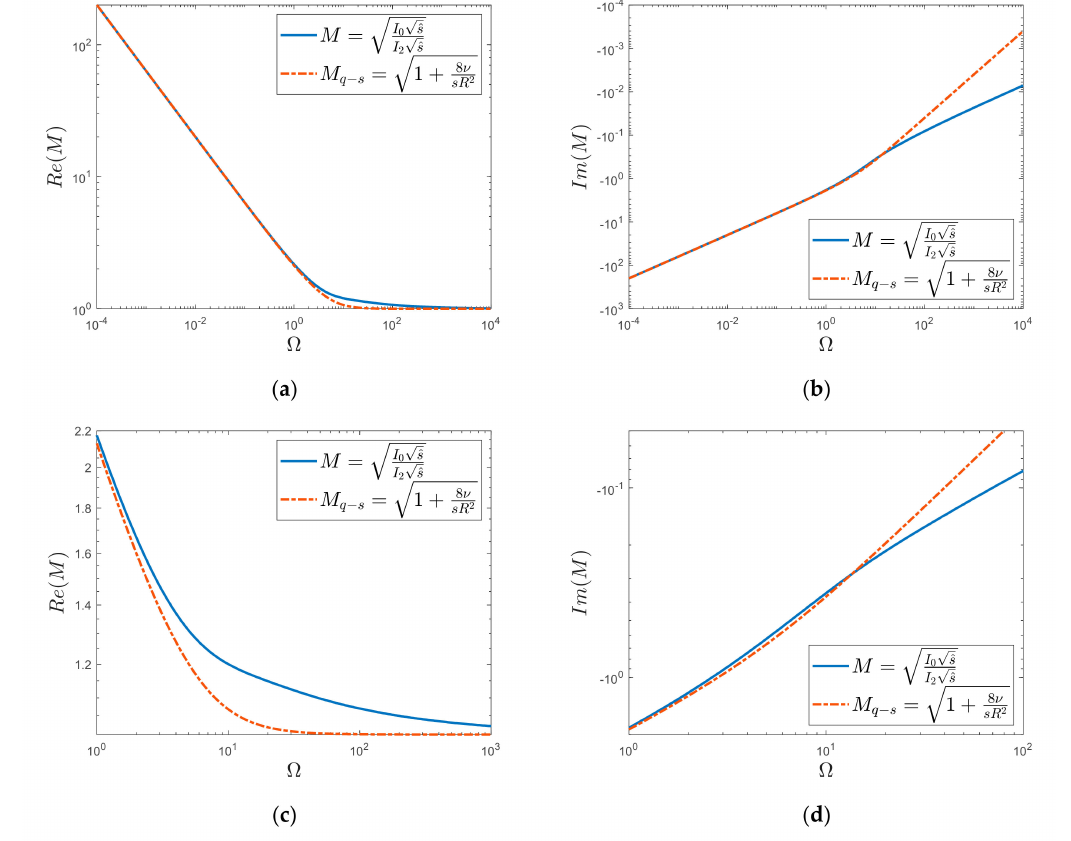
Figure 2. Course of dynamic viscosity function ( a ) Realis graph, ( b ) Imaginaris graph, ( c ) Enlarge of Realis graph, ( d ) Enlarge of Imaginaris